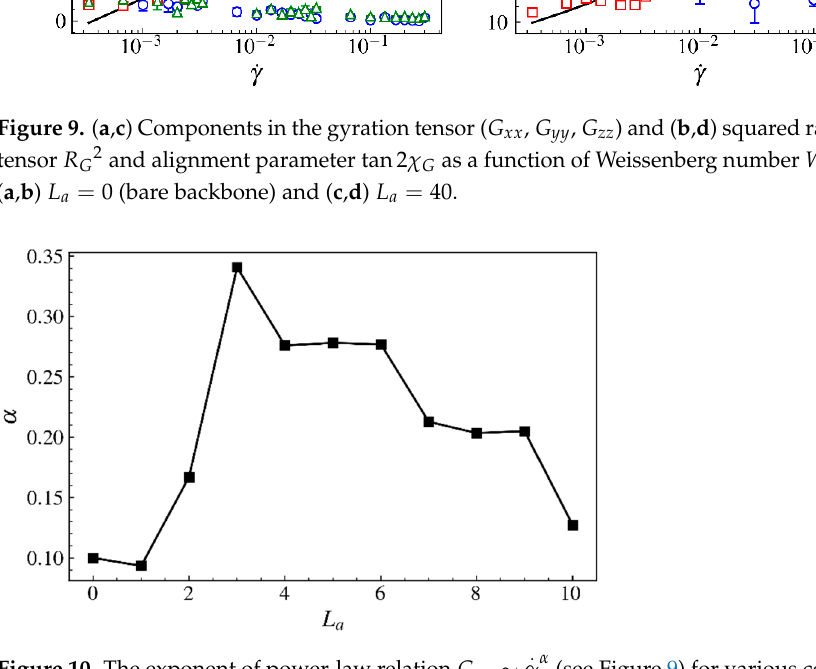
Figure 10. The exponent of power-law relation G xx ∼ as a function of the arm length.